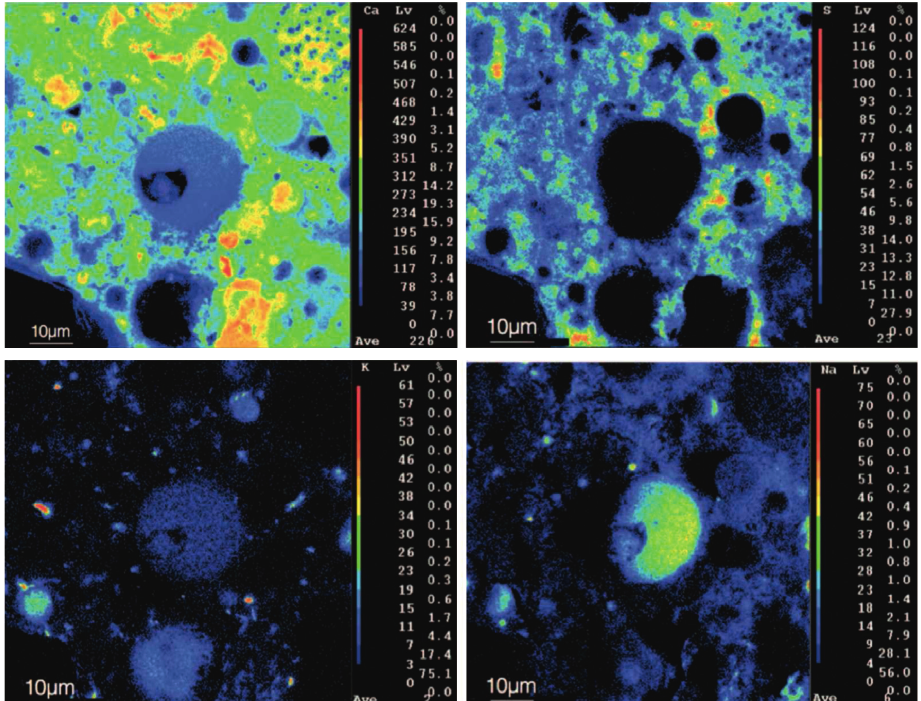
Figure 9: Element mapping of Ca, S, K, and Na in the same area in HVFA mortar at the curing age of 37d, reproduced from [86], with permission from American Society of Civil Engineers, 2021.